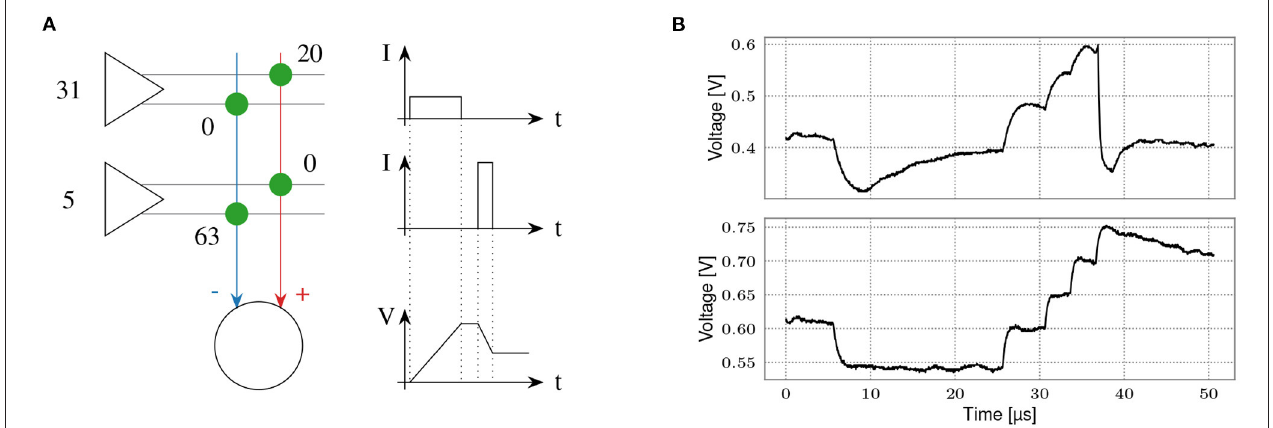
FIGURE 12 | Matrix-vector multiplication for ANN inference. (A) Scheme of a multiply-accumulate operation. Vector entries are input via synapse drivers (left) in 5 bit resolution. They are multiplied by the weight of an excitatory or inhibitory synapse, yielding 6 bit plus sign weight resolution. The charge is accumulated on neurons (bottom). Figure taken from Weis et al. (2020). (B) Comparison between a spiking (top) and an integrator (bottom) neuron. Both neurons receive identical stimuli, one inhibitory and multiple excitatory inputs. While the top neuron shows a synaptic time constant and a membrane time constant, the lower is configured close to a pure integrator. We use this configuration for ANN inference. Please note that for visualization purposes the input timing (bottom) has been slowed to match the SNN configuration (top). The integration phase typically lasts < 2 µ